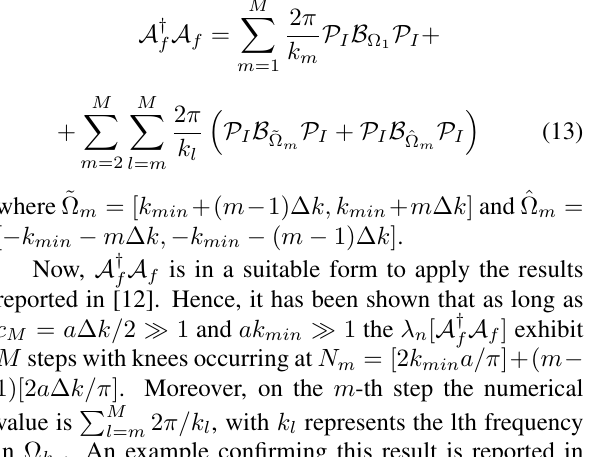
Figure 6: Singular value behavior of A f for the case of M = 3 frequencies k 0 min , 1 . 5 k 0 min and 2 k 0 min , k 0 min = 2 πm − 1 and a = 20 π/k 0 min